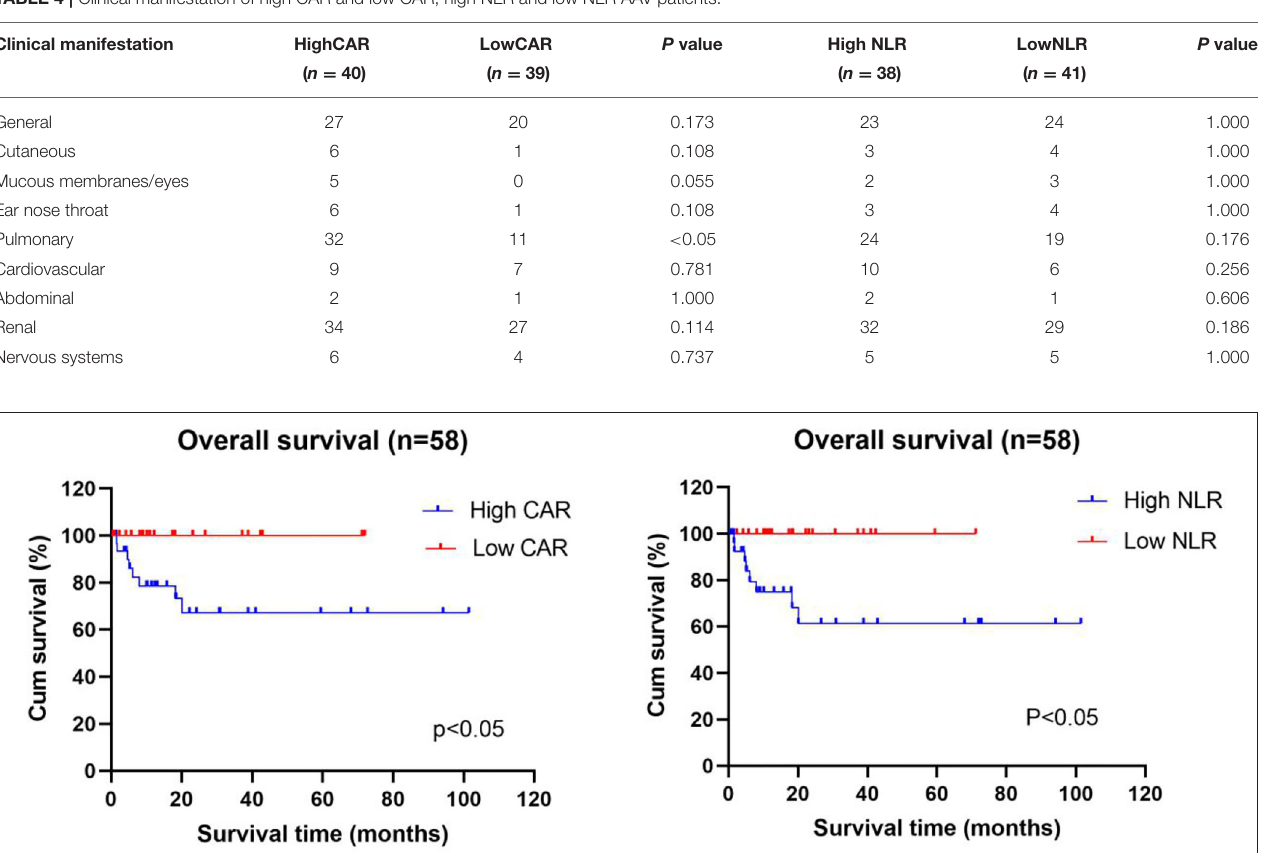
FIGURE 4 | Relationship between the CAR and NLR and the cumulative survival rate of newly diagnosed AAV patients. Kaplan–Meier survival analysis revealed that the all-cause mortality rate was higher in AAV patients with high CAR ( ≥ 0.8) and high NLR ( ≥ 5.15) than in patients with low CAR ( < 0.8) and low NLR ( < 5.15). CAR, C-reactive protein/albumin ratio; NLR, neutrophil/lymphocyte